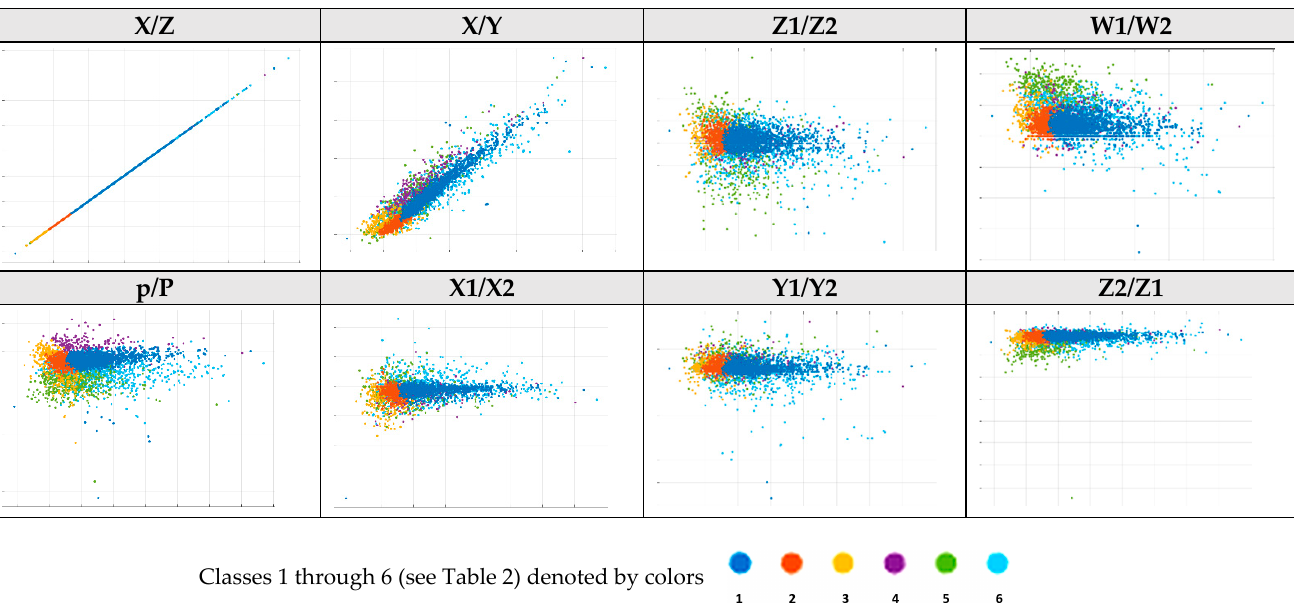
Figure 8. Distribution of the shape parameters.